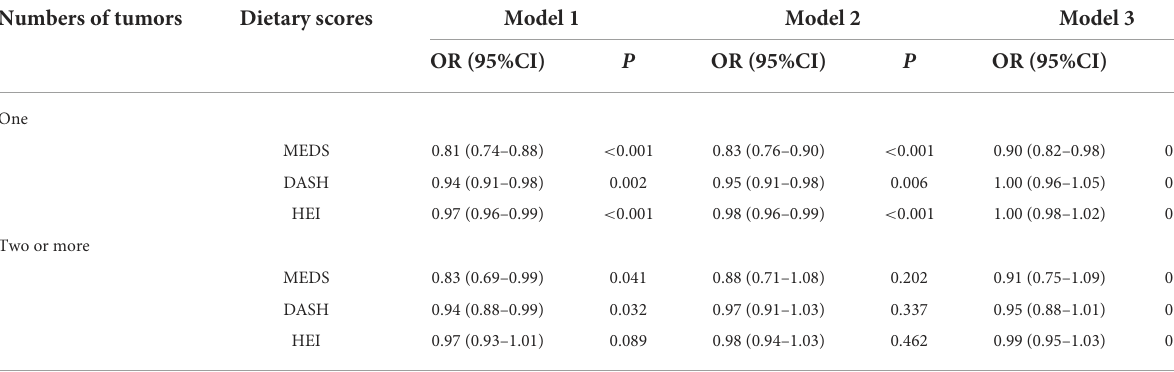
TABLE 6 Association analysis of dietary scores and depression in the number of tumors subgroup.